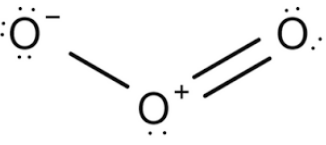
Figure 33. Chemical structure of ozone. Formula: O 3.